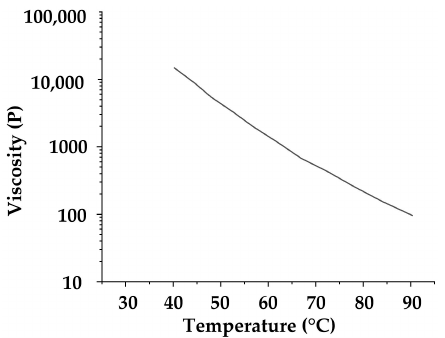
7 of 21 Figure 4. The resin conditions at three temperatures with magnification of the microscope is 30: ( a ) the condition at 15 °C; ( b ) the condition at 30 °C; ( c ) the condition at 45 °C.